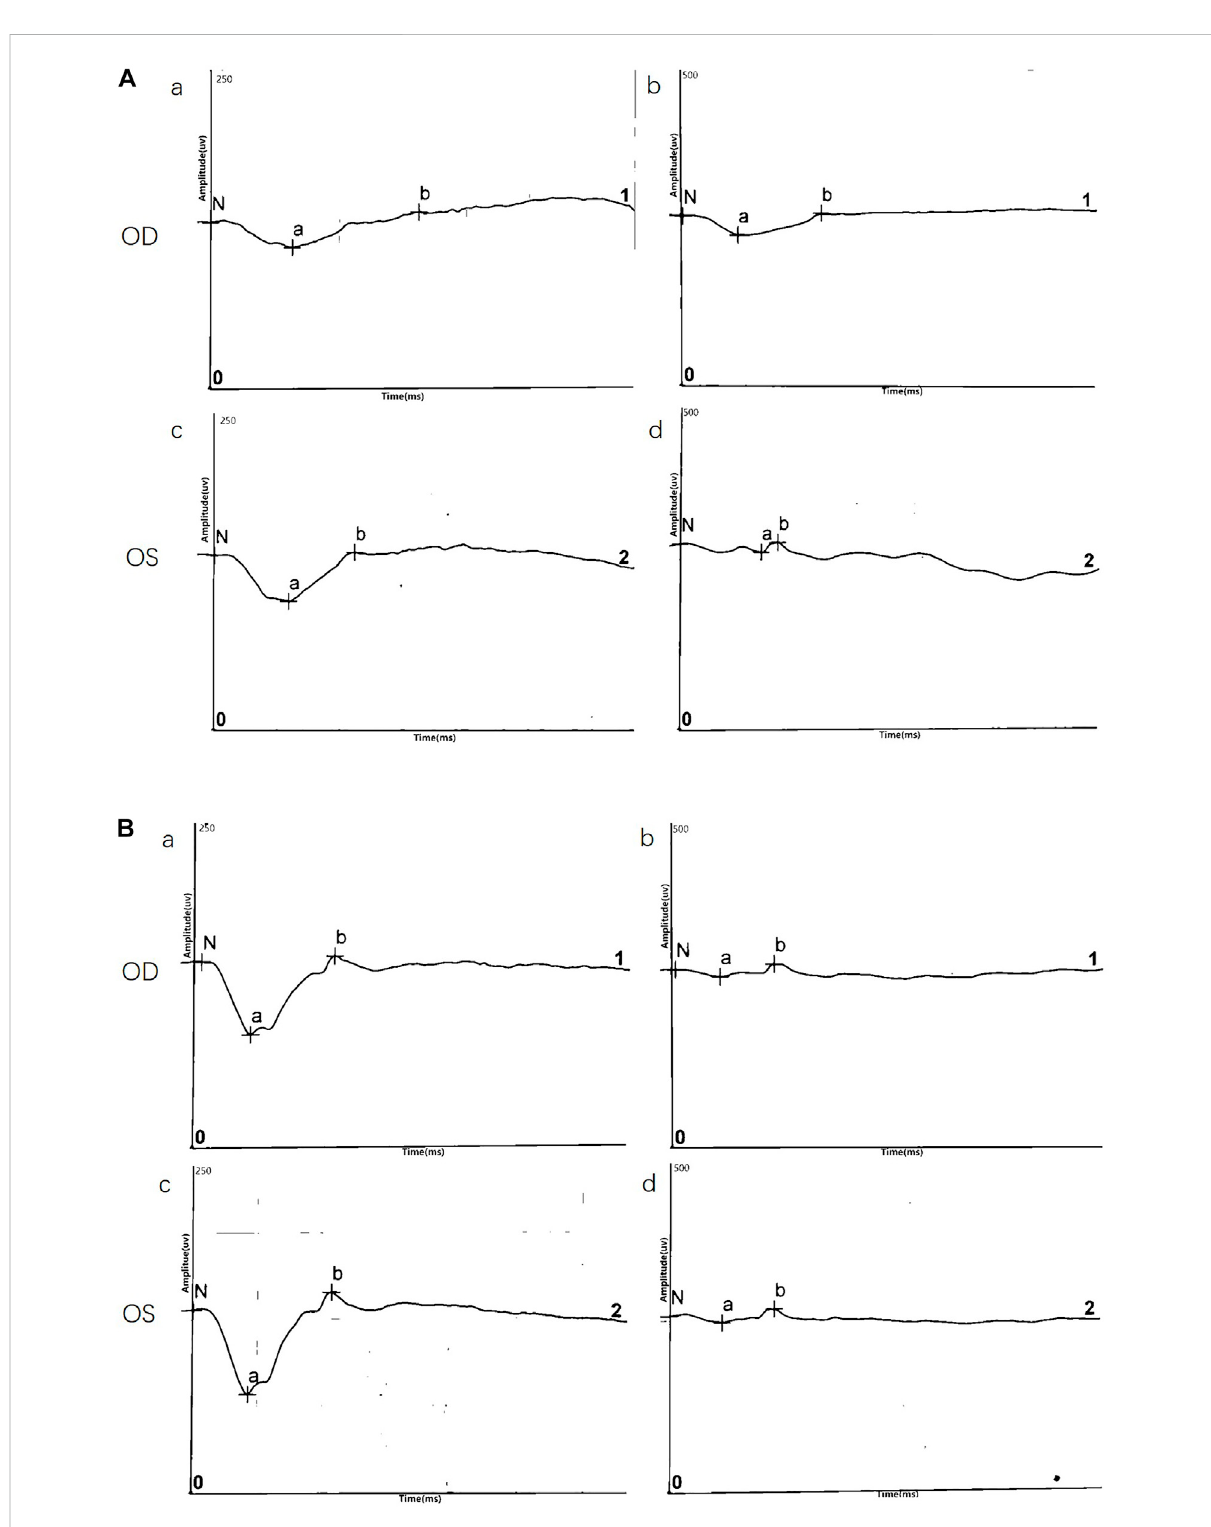
FIGURE 3 Representative electroretinography (ERG) responses. (A) ERG results of III:5 (B) ERG results of III:6. Left side: dark-adapted ERG (DA 3.0 ERG); Right side: light-adapted ERG (LA 3.0